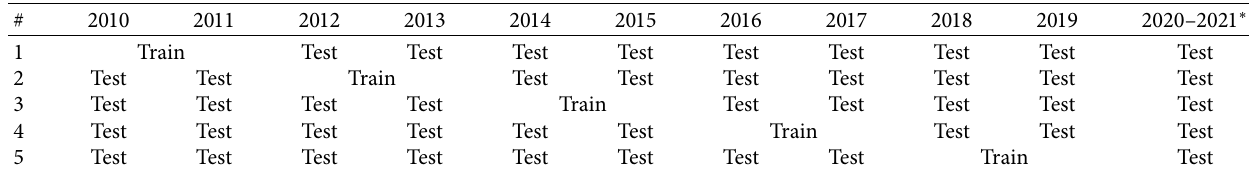
Table 1: Train and test sets.